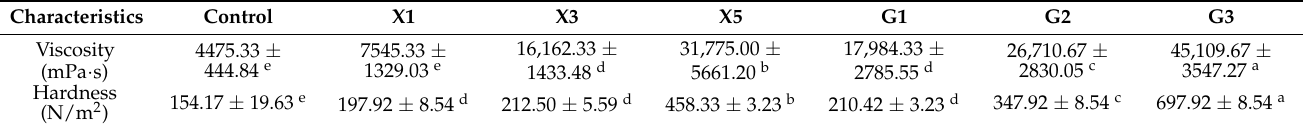
Table 5. Changes in viscosity and hardness of soymilk-based banana-blueberry-puree by adding thickeners XanFlax and brand